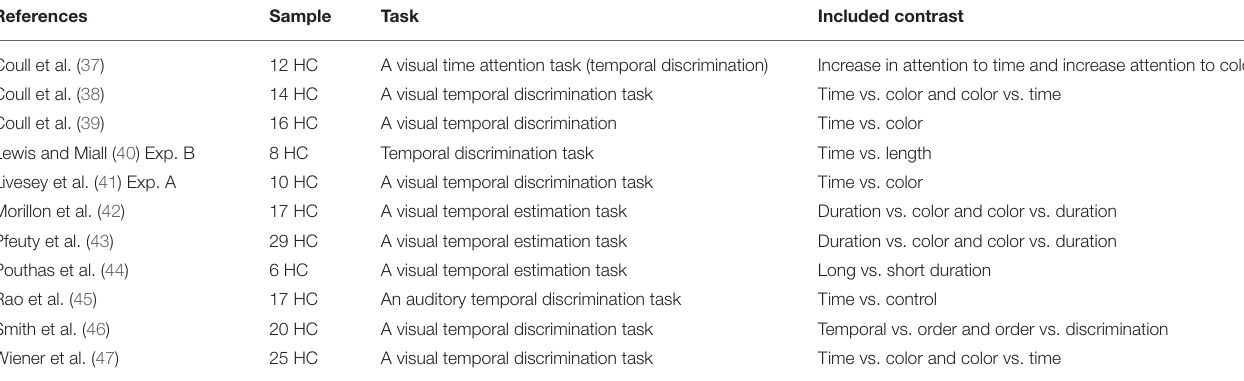
TABLE 1 | Studies of timing in HC included in our SDM-PSI meta-analysis.